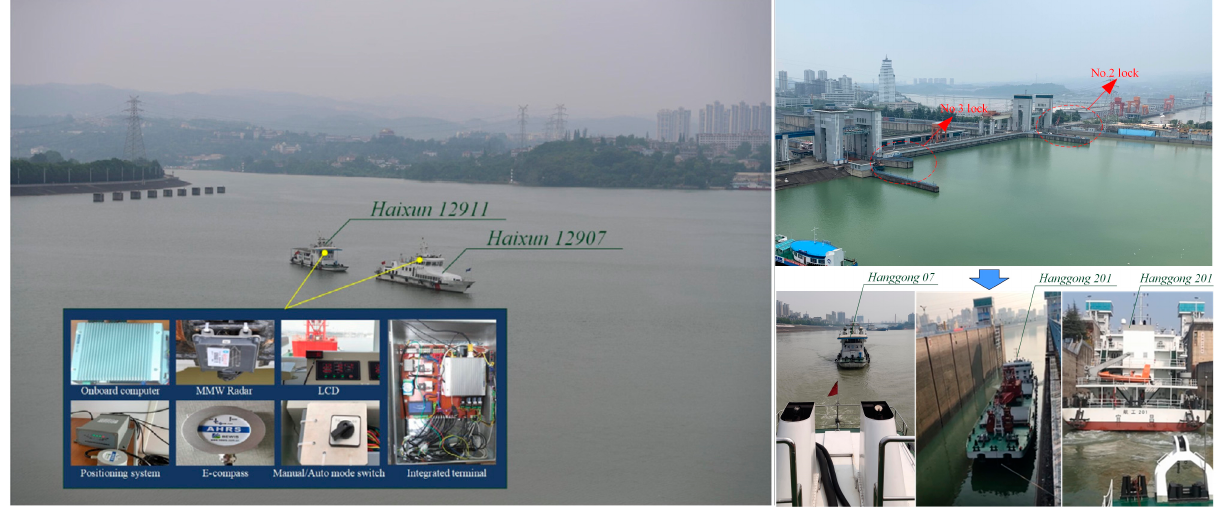
Figure 9. Vessel formation control tests in Gezhouba lock waterways.